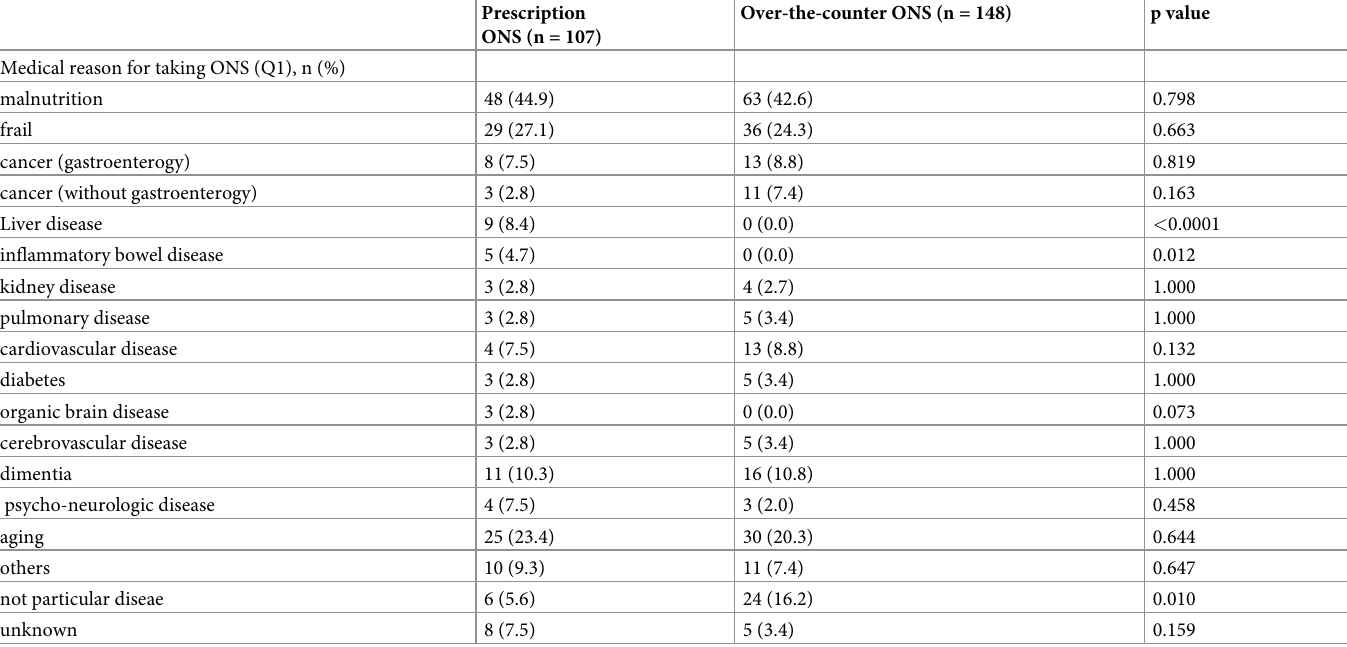
Table 5. Medical reason for taking ONS